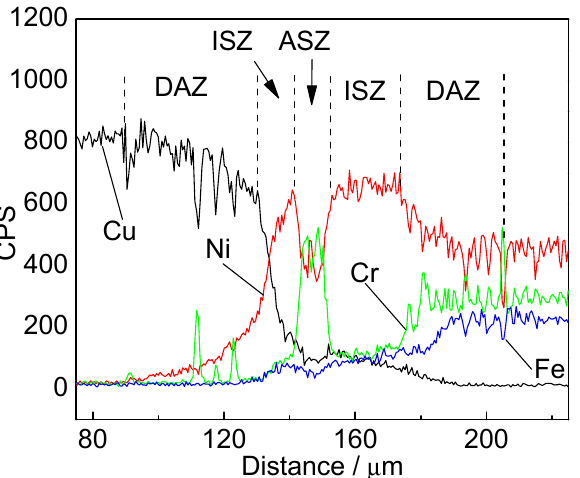
Figure 6. Concentration profiles of main elements across the joint interface of a sample bonded for 60 min.